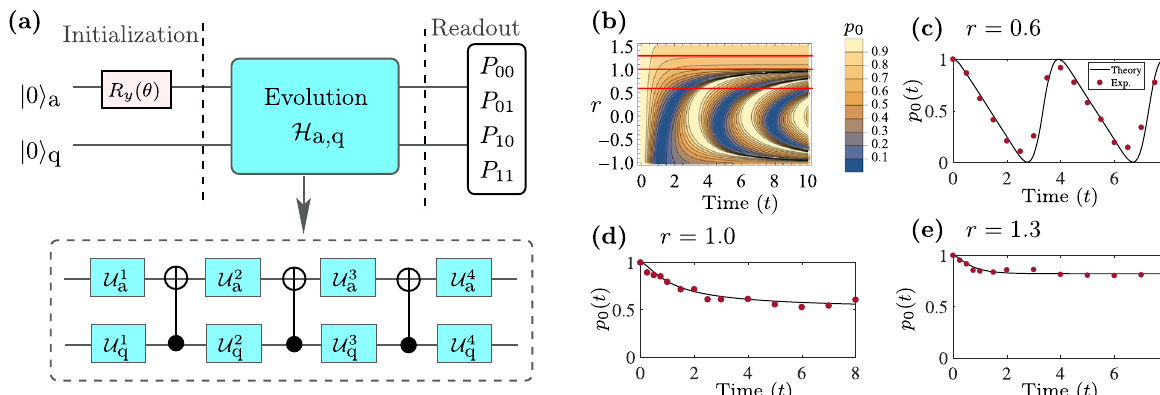
Fig. 1 Demonstration of PT -symmetry breaking for a single-qubit. a Quantum circuit implementing the dilated unitary operator U a,q in the four- dimensional Hilbert space of system and ancilla, where R y ( θ ) is a single-qubit rotation about the y -axis by an angle θ , and the subscript q(a) refers to the system qubit(ancilla). Details of the evolution under H a ; q are given in the inset. b Dynamics of the population p 0 of state 0 j i under the Hamiltonian H q for a range of parameters − 1 ≤ r ≤ 1.5. As the eigenvectors of H q coalesce at r = 1, the oscillations disappear, and beyond this point, PT -symmetry breaking is observed. The plots in c – e present the results of the experiments (red dots) run on the IBM quantum experience (with 8192 repetitions) for the parameter r taking values r = 0.6, 1.0, and 1.3 respectively. The data matches well with theory (continuous black lines) corresponding to the three red lines from panel ( b